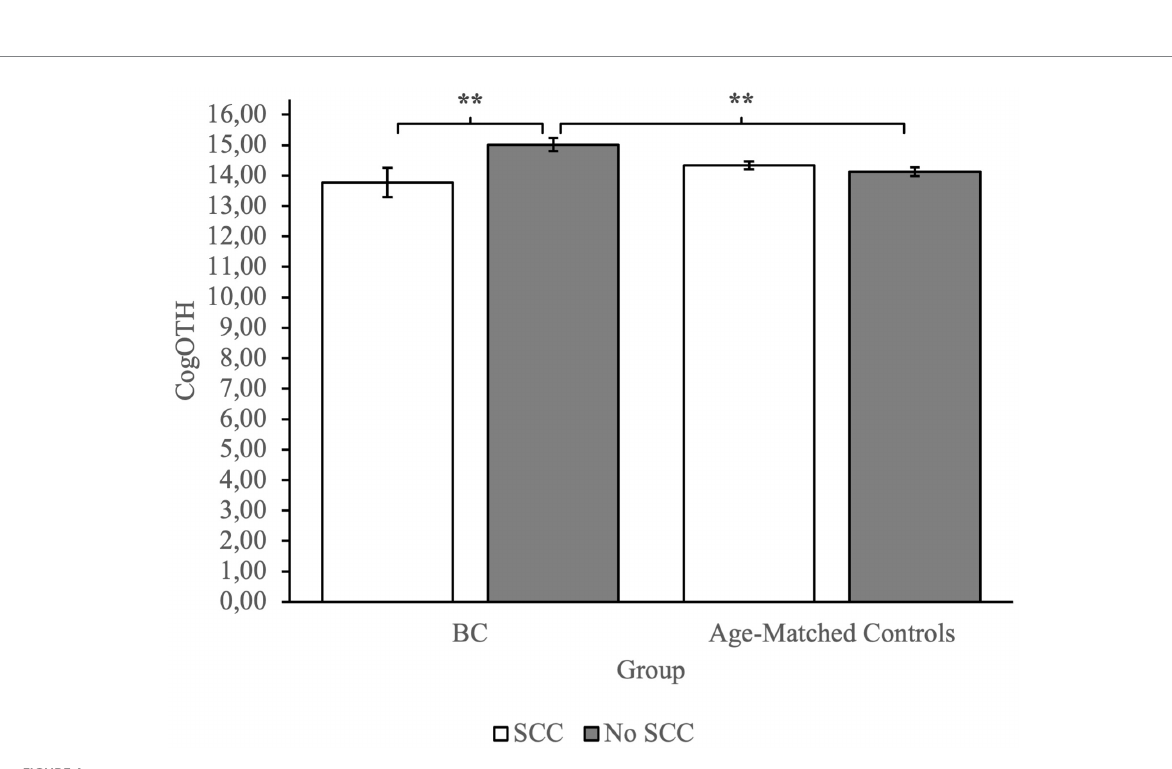
FIGURE 4 Group comparison between FACTCog comments from others (OTH) measures: BC patients not referring SCC are described by others with more cognitive functionality compared to BC patients referring SCC and age-matched controls not referring SCC. ** p <